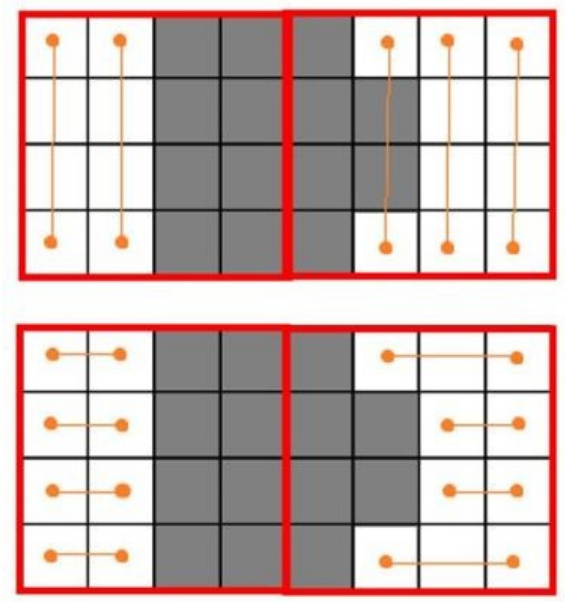
Figure 12. Space organization of an office block: inspection of internal jumps (staircase rule).